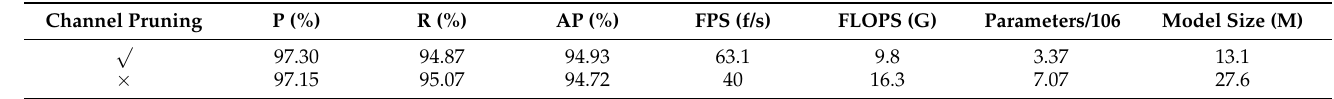
Table 8. Ablation study of YOLOv5-AC with and without channel